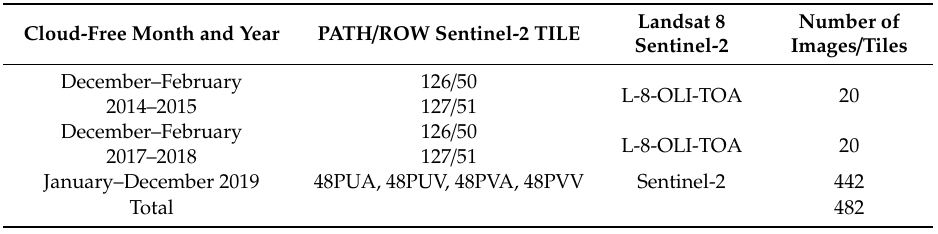
Table 2. Landsat OLI and Sentinel-2 image collections used in this study for phenology-based threshold classification (PBTC).